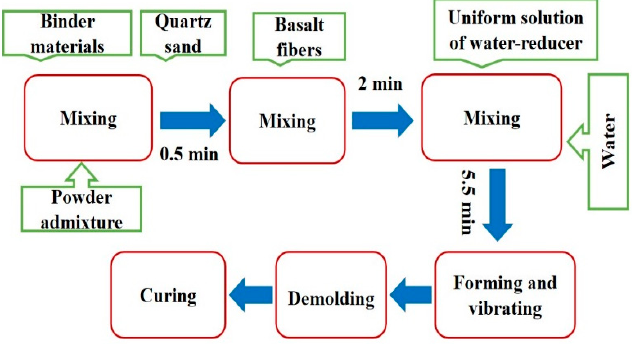
Figure 1. The manufacturing process of the specimens.